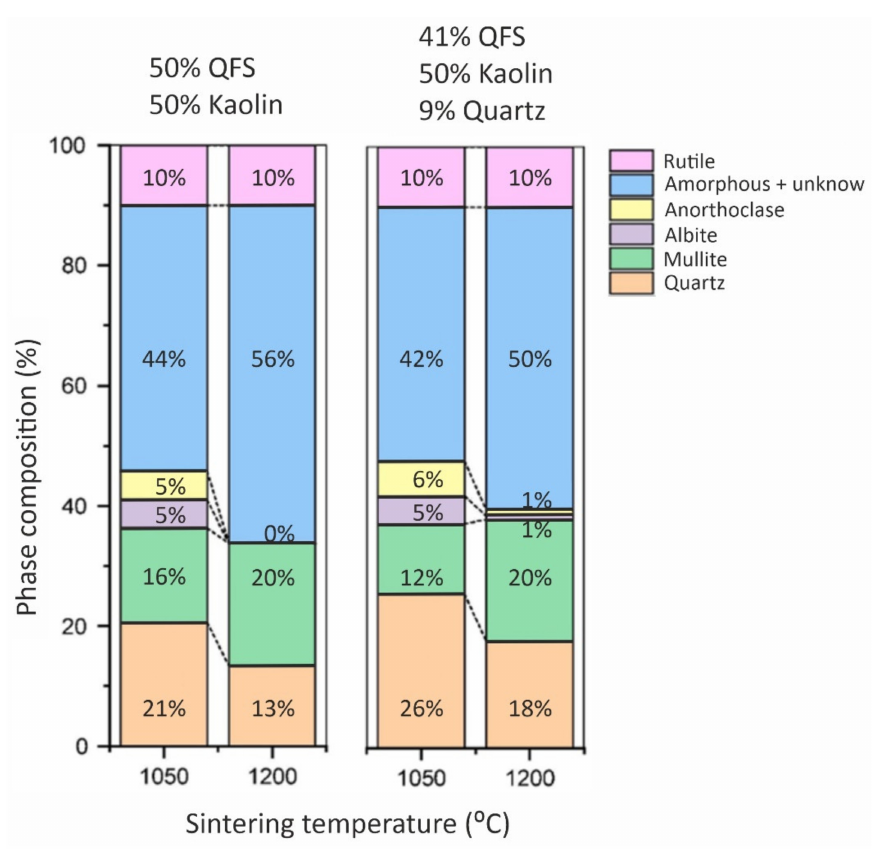
Figure 7. Phase composition of investigated compositions at indicated temperatures